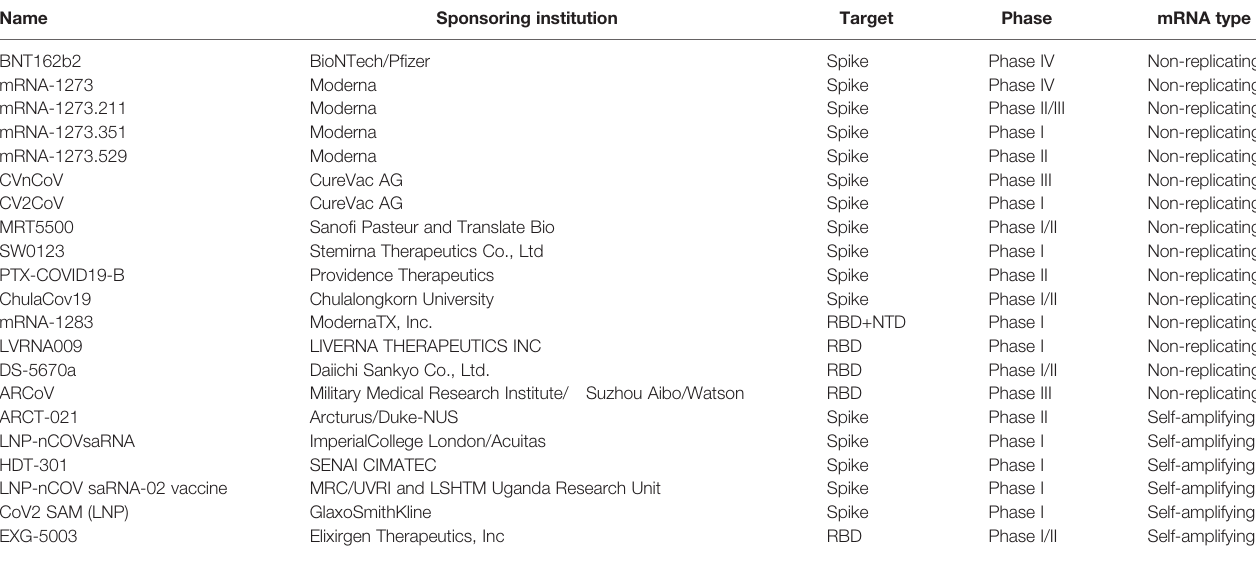
TABLE 2 | Clinical trials of mRNA vaccines against SARS-CoV-2.